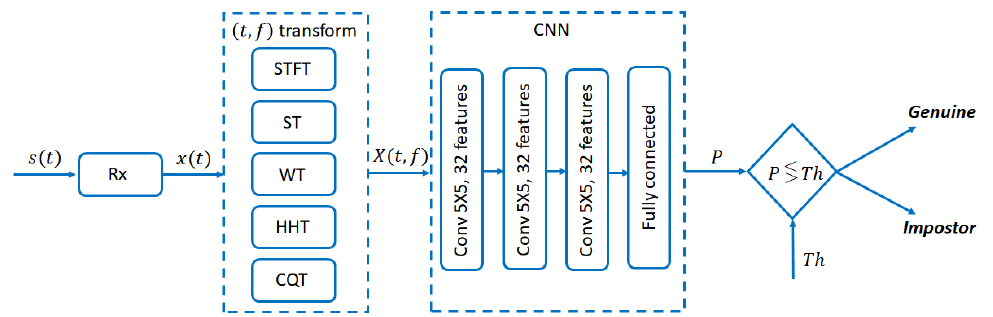
Figure 4. Processing chain of the proposed system. The acquired signal s ( t ) is demodulated and filtered by the receiver Rx , obtaining the base-band signal x ( t ) . X ( t , f ) is subsequently computed by means of a time/frequency transformation and provided as input to the CNN. Its output, i.e., the membership score P , is compared to the threshold Th in order to obtain the genuine/impostor detection.